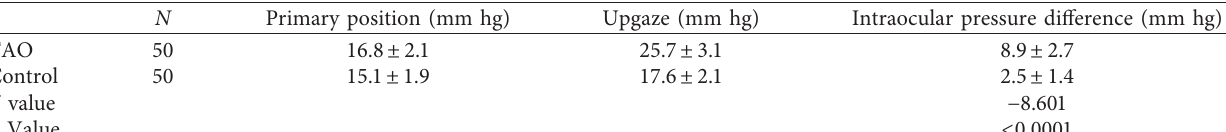
Table 2: Comparison of IOP at different ocular positions between TAO group and control group.